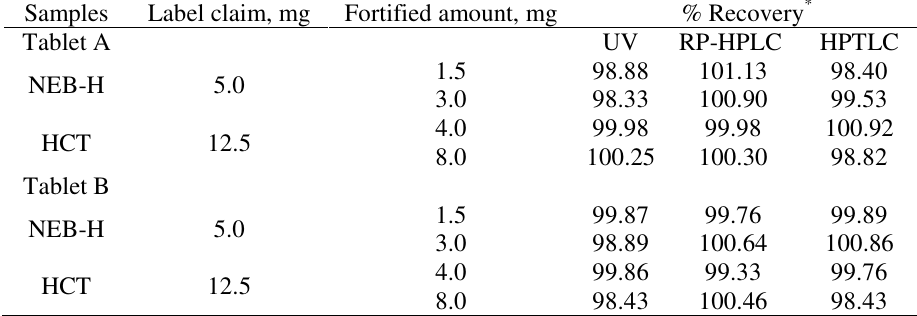
Table 3. Recovery studies of nebivolol hydrochloride and hydrochlorothiazide. Samples